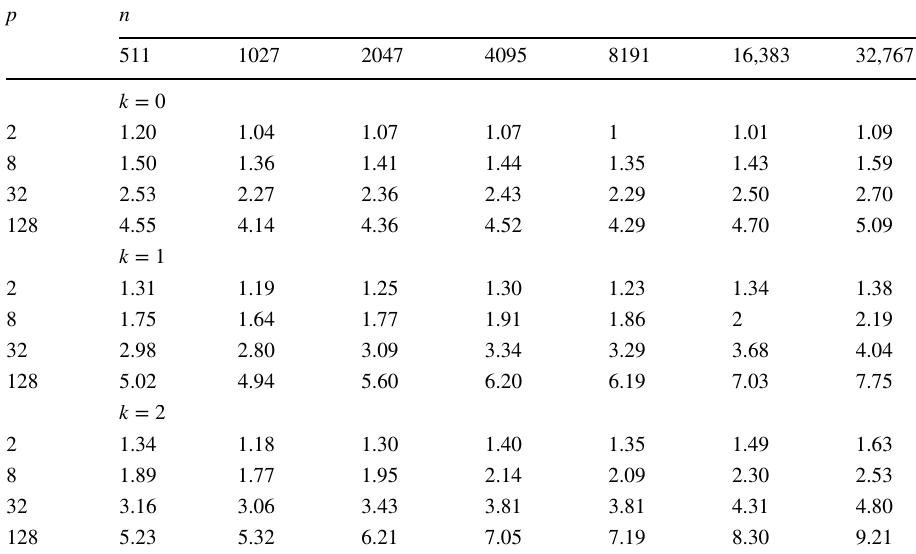
of our algorithm for p ∈ { 2,8,32,128 } , n ∈ { 511,1023, … ,16,383,32,767 } 0,1,2 and k ∈ {